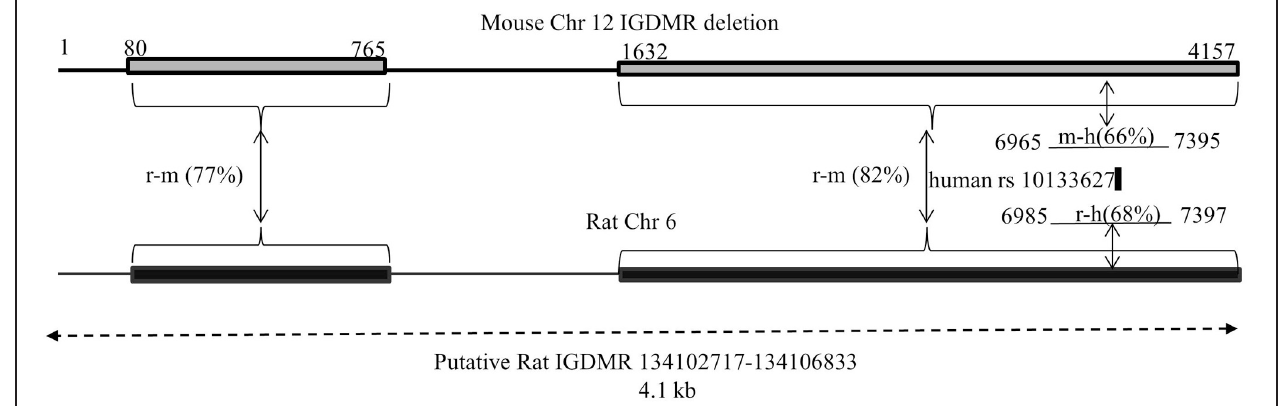
FIGURE 2 | Mapping the Dlk1-Dio3 IGDMR on chromosome 6 in the rat. Lin et al. created a targeted deletion of 4.15kb of the mouse IGDMR [Chr 12, AJ320506 nt 79883–84039, top (Lin et al., 2003)]. When transmitted maternally, the deletion affects imprinted expression of the genes in the Dlk1-Dio3 locus. We compared the deletion sequence to rat Chr 6 by NCBI’s BLAST, defining the resulting homologous regions (rat-mouse 77 and 82%, respectively) and the intervening sequence on rat Chr 6 as the putative rat IGDMR. In the human, a maternally transmitted familial heterozygous 8.5kb